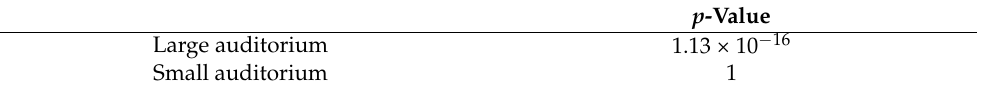
Table 2. p -values calculated with the Mann–Whitney U test checking whether the COVID-19 aerosol transmission risk estimations in 2021 are lower than in 2020 for the large and small